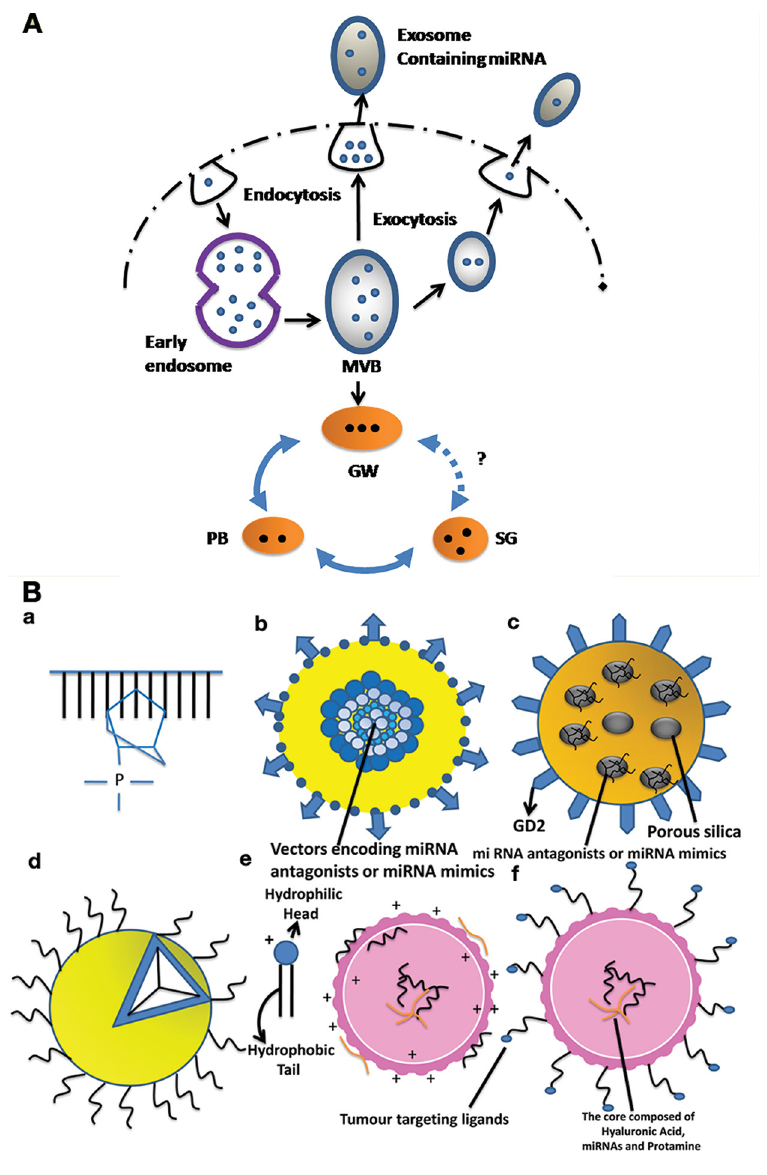
Figure 5. (A) Trafficking and delivery vehicle of miRNA in cells, the specific miRNA endocy-toses into endocytic vesicles that generate early endosome. Many endogenous miRNAs are involved in RNA granule formation, including glycine and tryptophane-rich bodies (GW), processing bodies (PB), and stress granules (SG), which invariably fuse with multi-vesicular bodies (MVB) and the plasma membrane. Then exosomes are released through exocytosis into the extracellular space. Reproduced with permission (169). (B) Different processes for miRNA delivery in vivo. Numerous strategies, including modified miRNA, antagonistic or miRNA mimics, viral vector, organic and nonorganic viral vectors were used for therapeutic delivery. (a-f) Different types of modified nanoparticles are used for miRNA delivery. (b) Viral vector system for delivery (c) Silica nano particles used for delivering in overexpressed tumors; (d) Polymer based organic non-viral vector for gene therapy; (e) nano particle based on liposome; (f) modulated with anti-bodies or ligand for cancer associated delivery. Figure reproduced with permission of Elsevier B.V. Chen Y, Gao D-Y, Huang L. (2015) In vivo delivery of miRNAs for cancer therapy: Challenges and strategies. Adv. Drug Del. Rev. 81:128–41. (cited as reference [156] in the current